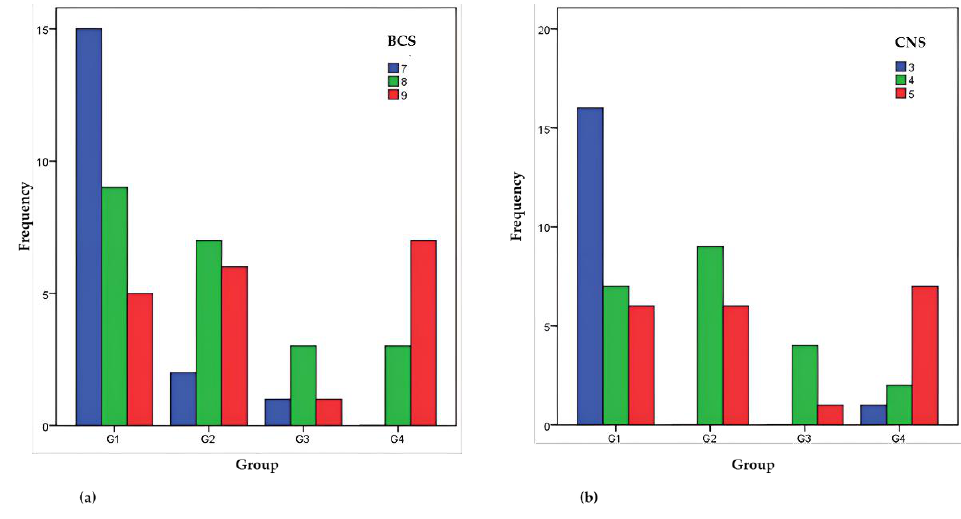
Figure 5. The frequencies of the horses in the four groups according to the BCS ( a ) CNS ( b ). The frequency distributions of BCS and CNS variables compared between the groups using the Kruskal–Wallis test differed significantly ( p < 0.05) (Table 6). The lowest BCS values are in group G1, followed by those in group G3, and the highest in group G4. Likewise, the lowest CNS values are in group G1, followed by those in group G3, and the highest in group G4. The results indicated that low BCS and CNS values are more frequent in Group 1, while high BCS and CNS values are predominant in Group 4 correlated well ( p < 0.001) with bodyweight that is lowest in Group 1 and highest in Group 4 (Table 7, Figure 6). Table 6. Results of Kruskal – Wallis test used to compare BCS and CNS ranks. Group